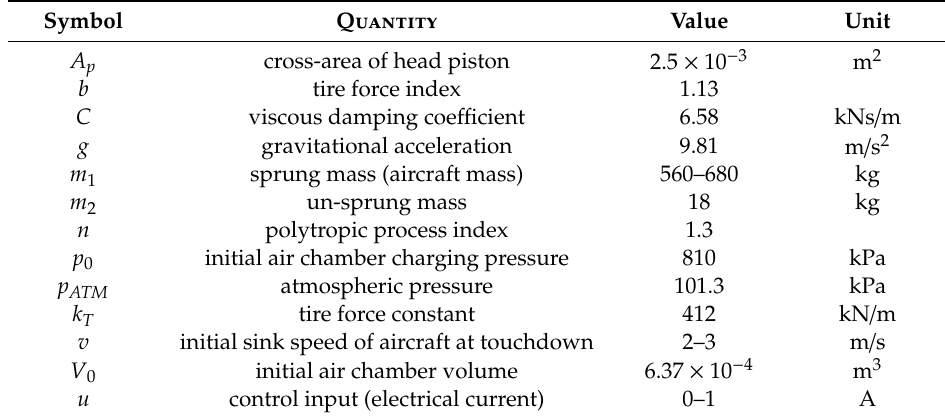
Table 1. Landing gear